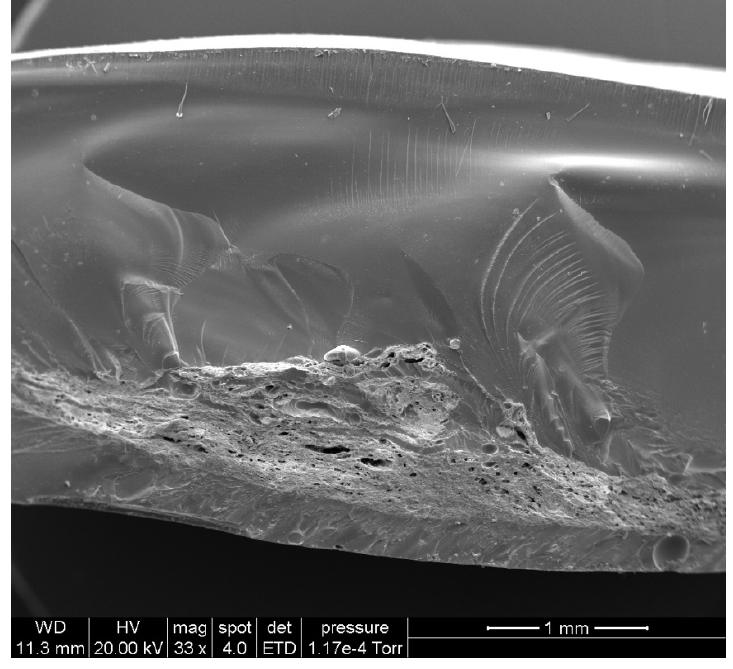
Figure 10. SEM image of sample 3D nanofibres filled Concise showing clear aggregation of the nanofibre filler at the base of the sample. This suggested that the 3D integrity of the nanofibre mesh had not been preserved in the process of resin